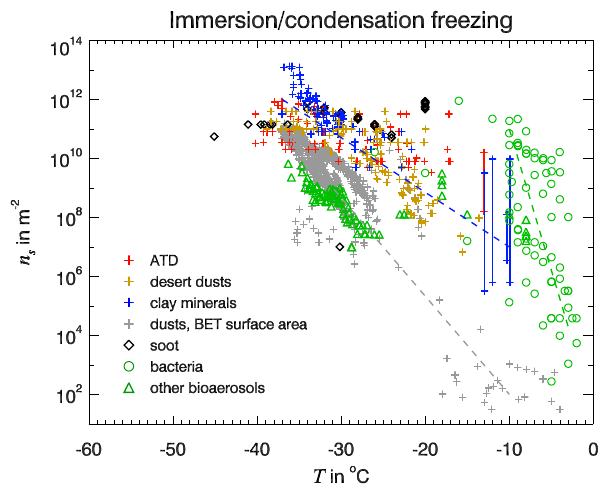
Fig. 13. INAS densities for ATD, kaolinite, natural desert dusts, soot and bioaerosols for immersion freezing, including deposi- tion/condensation freezing experiments at or above water satura- tion. The data sources are the same as in Figs. 11 and 12. The lines are inserted to guide the eye. The blue line refers to both ATD, desert dusts and clay minerals. The green line refers to highly INA biological